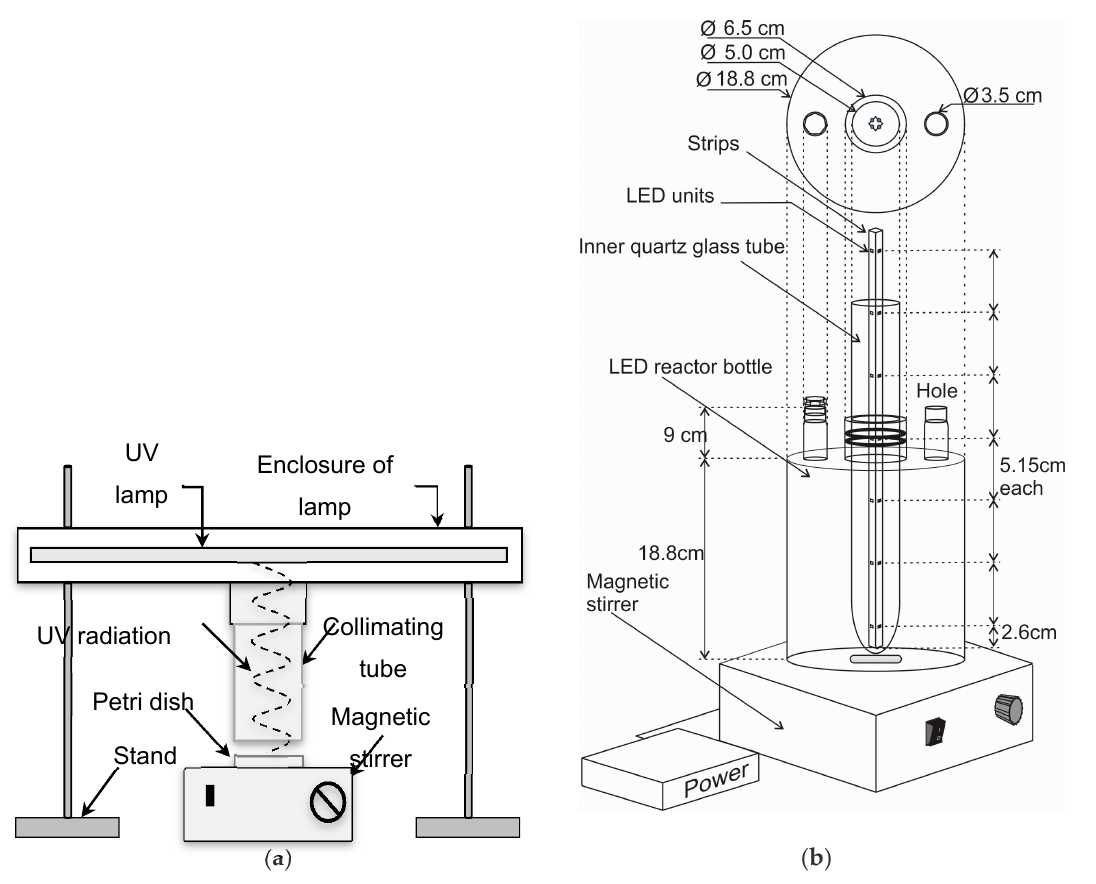
Figure 1. ( a ) Reactor type of 10 mL for Hg ‐ UV in collimator; ( b ) Reactor type of 5.2 L for UV ‐ LED with four LEDs at three different heights inside the water.